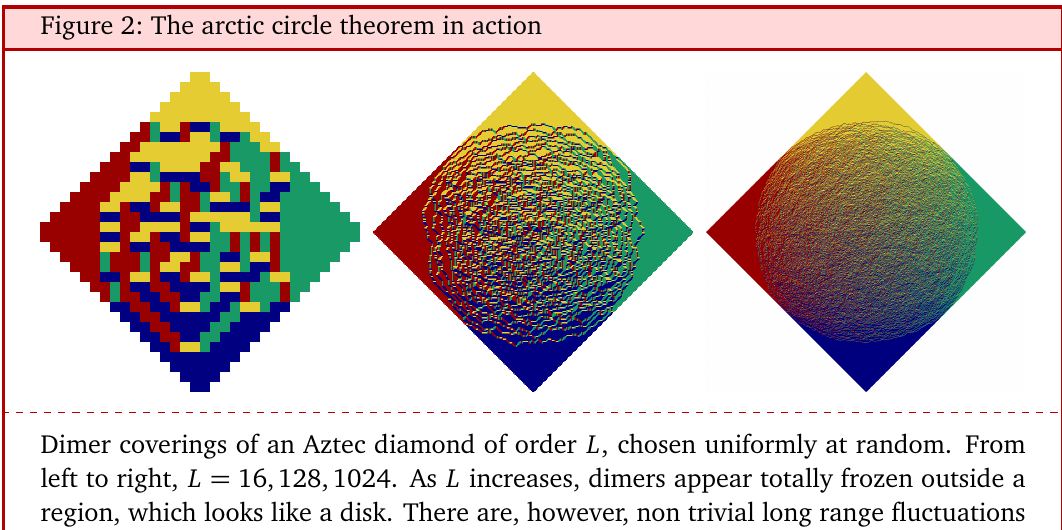
Dimer coverings of an Aztec diamond of order L , chosen uniformly at random. From left to right, L = 16,128,1024. As L increases, dimers appear totally frozen outside a region, which looks like a disk. There are, however, non trivial long range fluctuations inside the